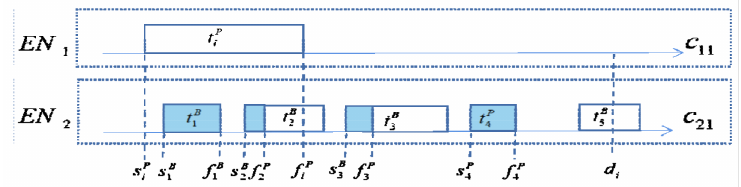
Figure 5. Unschedulable time slot for backup